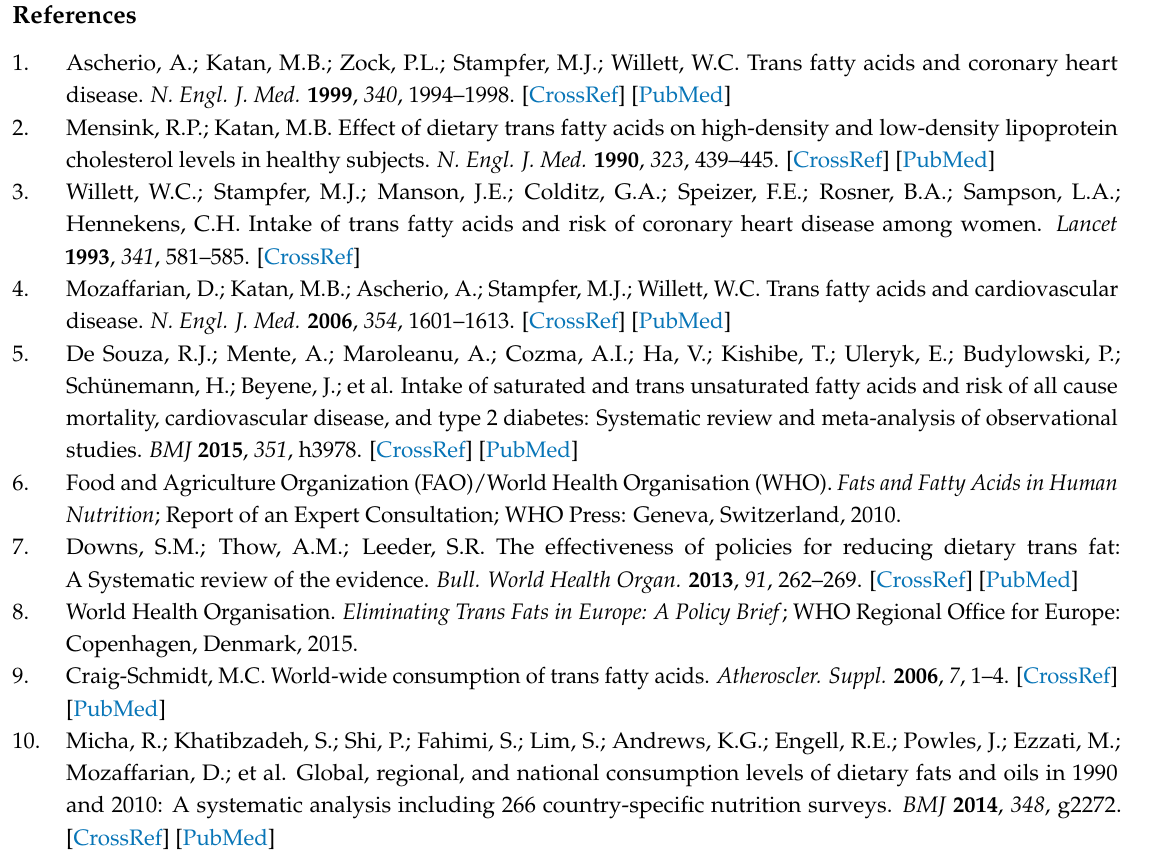
Figure S1: PRISMA flow chart; Table S1: Criteria for evaluating scoring the data quality; Table S2: Mean trans fat and saturated fat composition of biscuits in 17 countries; Figure S2: Time trends of mean trans and saturated fat content of biscuits in 5